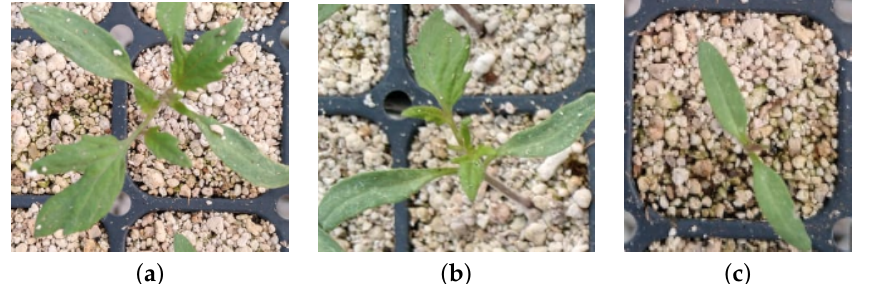
Figure 3. Main procedure divided into four general stages. Tray extraction, seedling segmentation, features extraction: height and development, and classification of four classes.